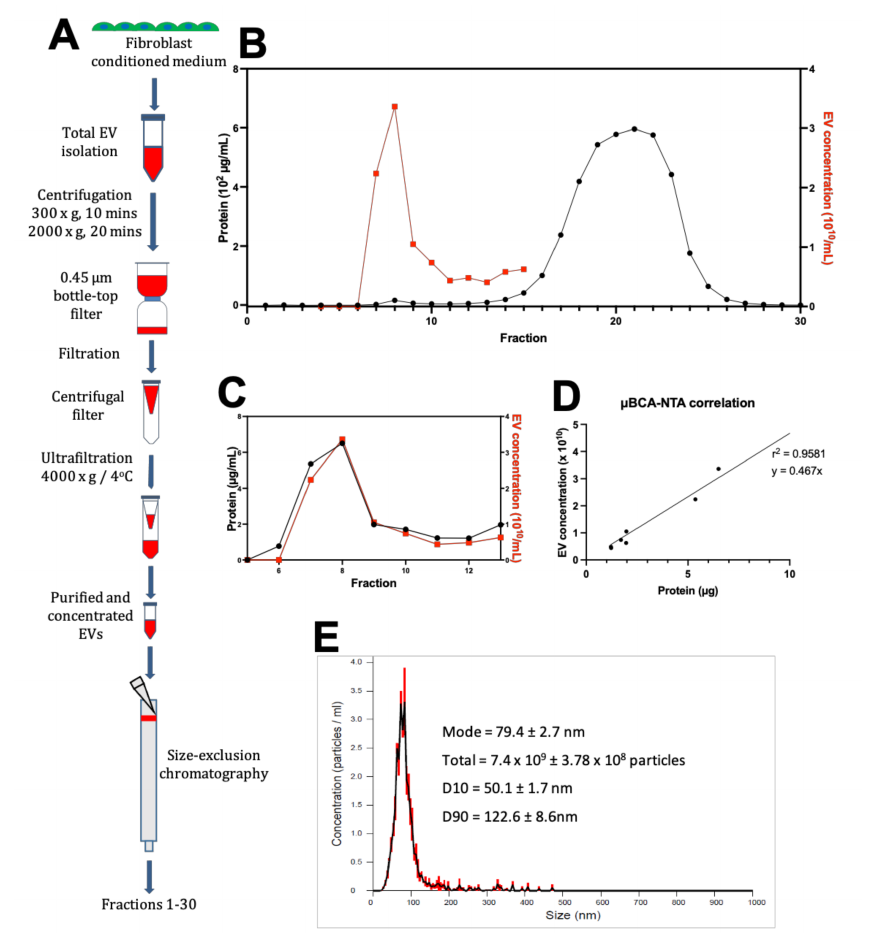
Figure 1. Isolation and purification of human fibroblast extracellular vesicles (EVs). ( A ) EVs were isolated from cultured human cardiac fibroblasts by a series of centrifugation followed by